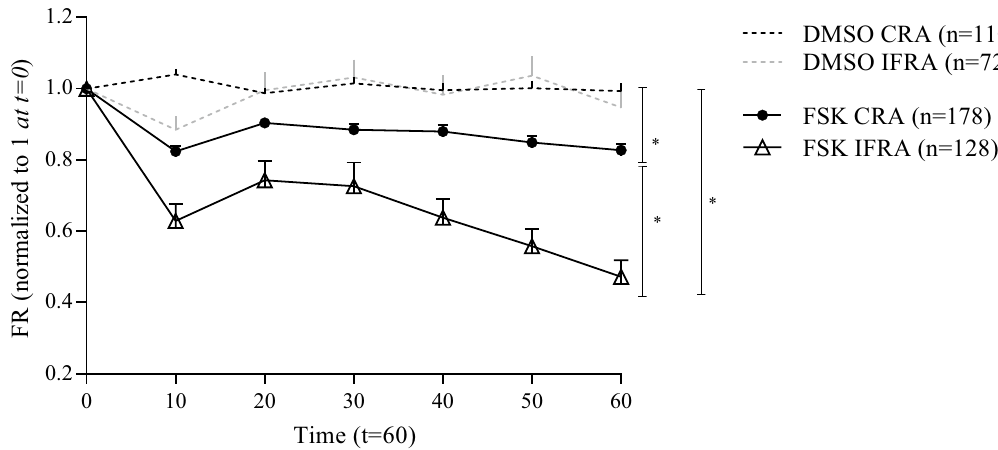
Figure 4. Cross-sectional areas (CRA) and inner fluid reservoir areas (IFRA) analysis of WT nasospheroids from different healthy WT subjects. Spheres were analyzed by live-cell imaging after DMSO or FSK incubation. Dots and triangles show mean FR values up to 60 min. Bars represent SEM. Both CRA and IFRA results present significant differences between the DMSO and the FSK stimulus. T-test also showed statistically different results for CRA and IFRA (* p = 0.0316; paired t-test). Calculated AUC also showed significant differences between CRA and IFRA trajectories (**** p < 0.0001). Similar results were observed after analysing slopes (results